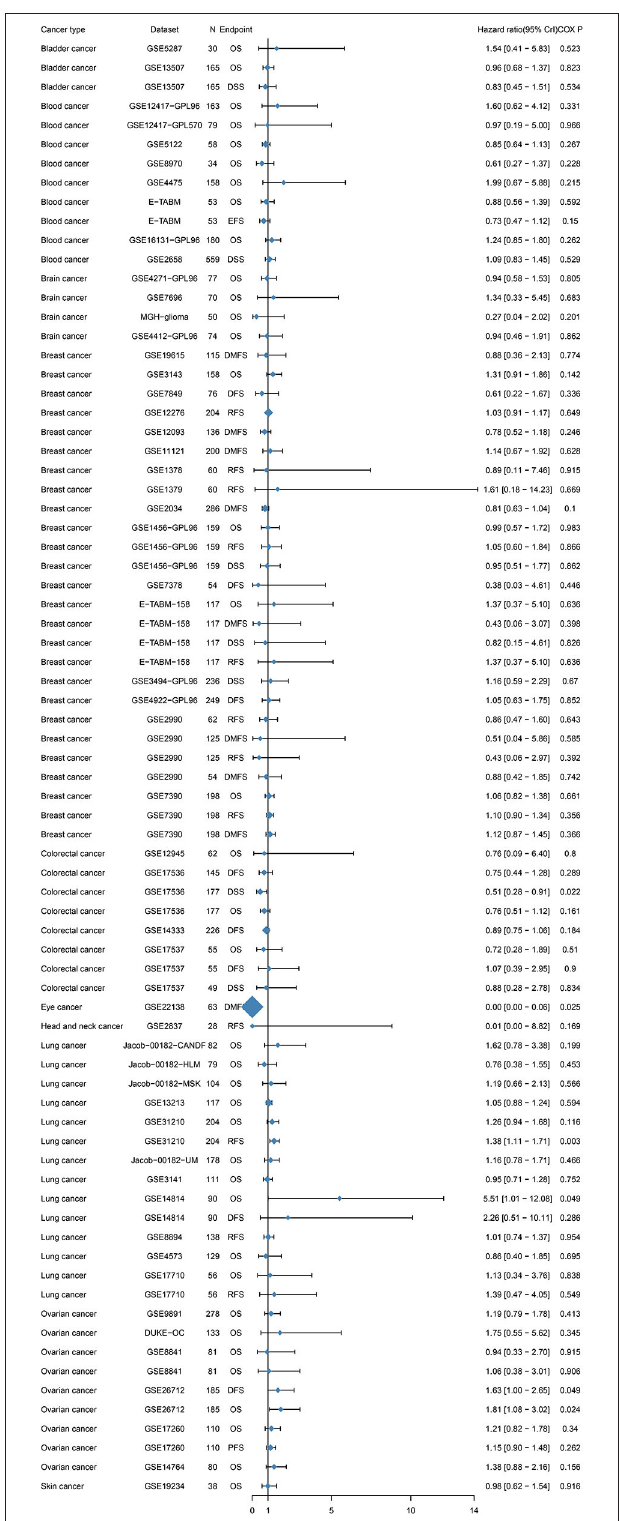
FIGURE 4 | Relation between TIM-1 expression and patient prognosis of different cancers in Prognoscan